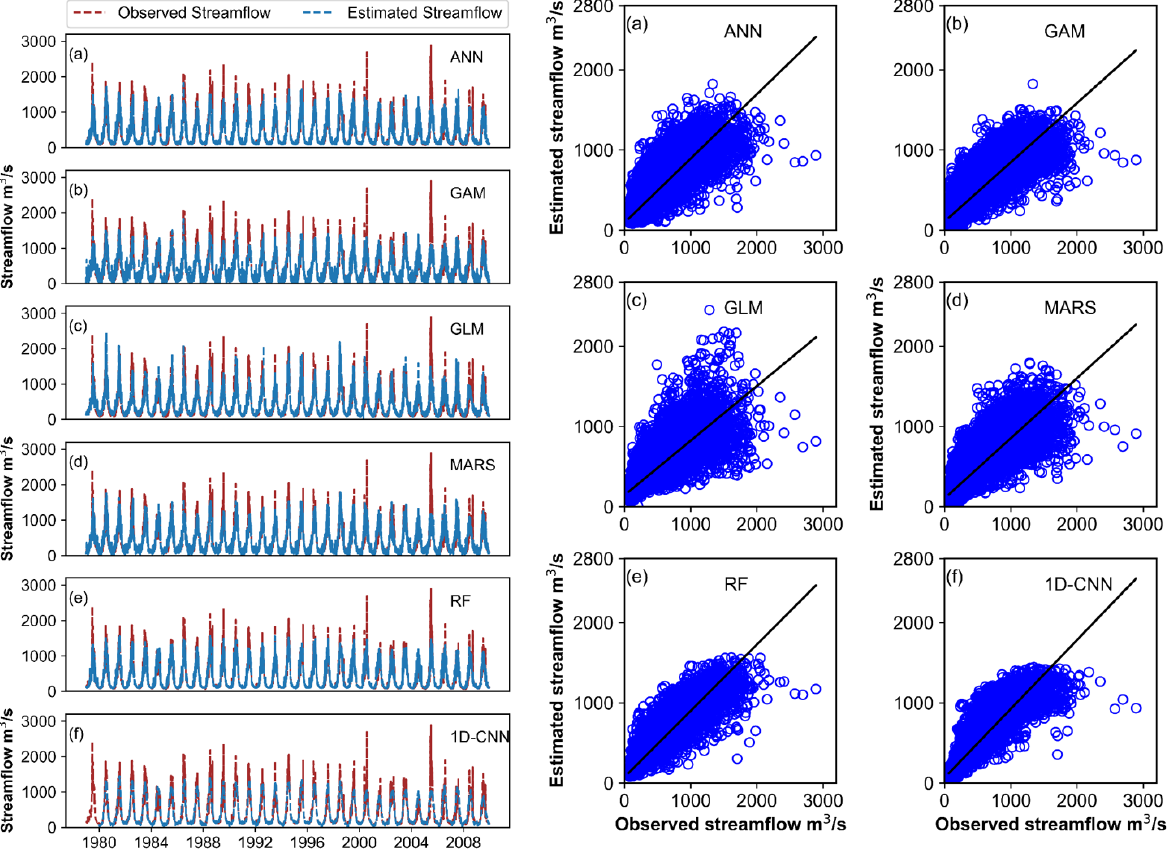
Figure 8. Comparison of observed and simulated streamflow for all six models (ANN, GAM, GLM, MARSs, RF, and 1D-CNN) under rainfall scenarios R 3 .